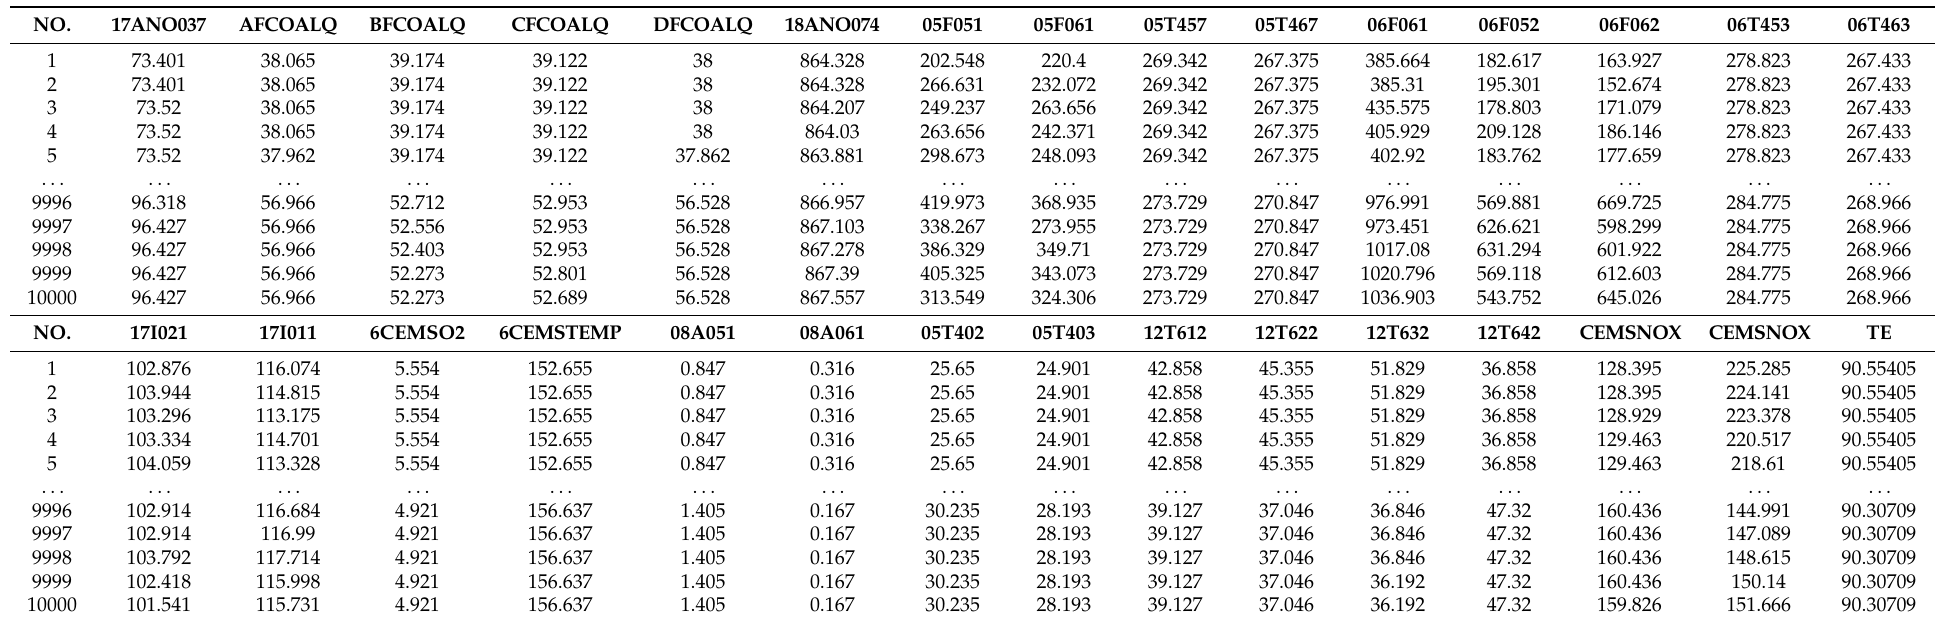
Table 7. The partial data of a 330MW CFBB operational